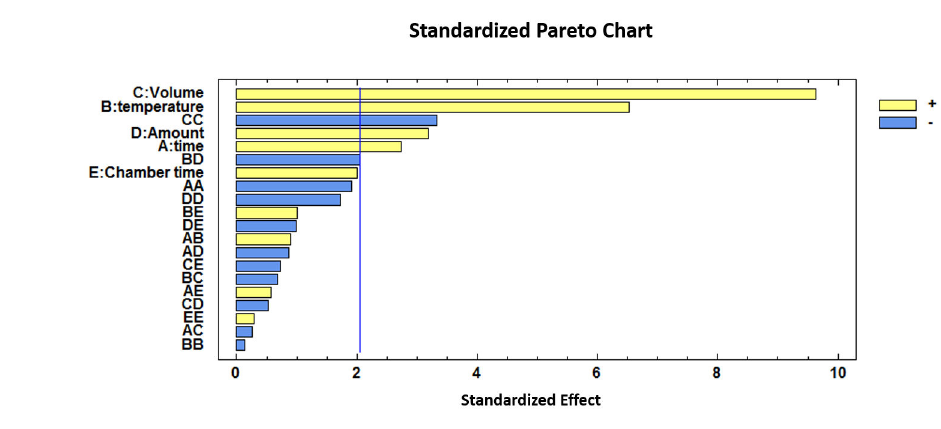
Figure 2. Standardized Pareto Chart representing the five variables optimized for the discrimination between unadulterated honey and HFCS (high fructose corn syrup)